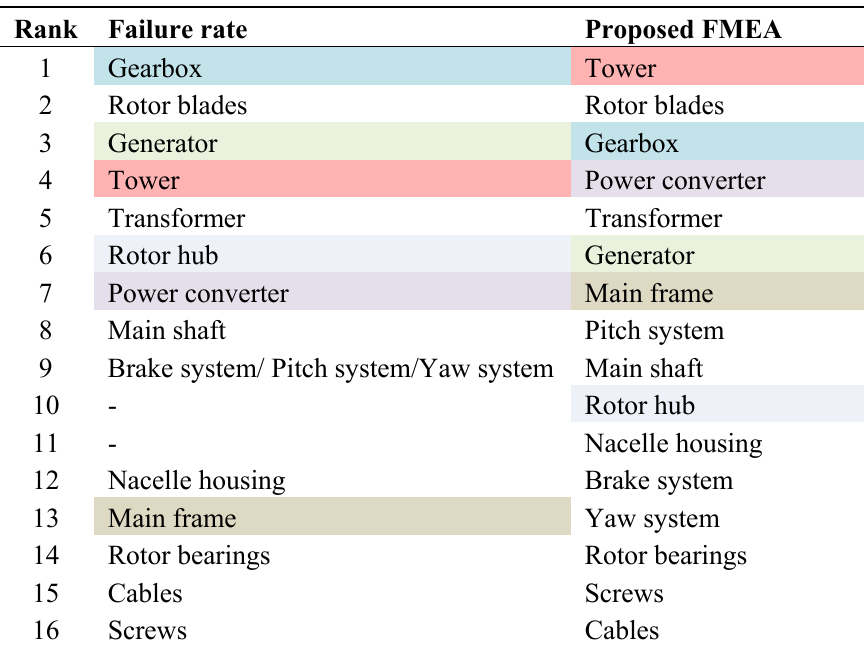
Table 10. Ranking comparisons between “failure rate” and